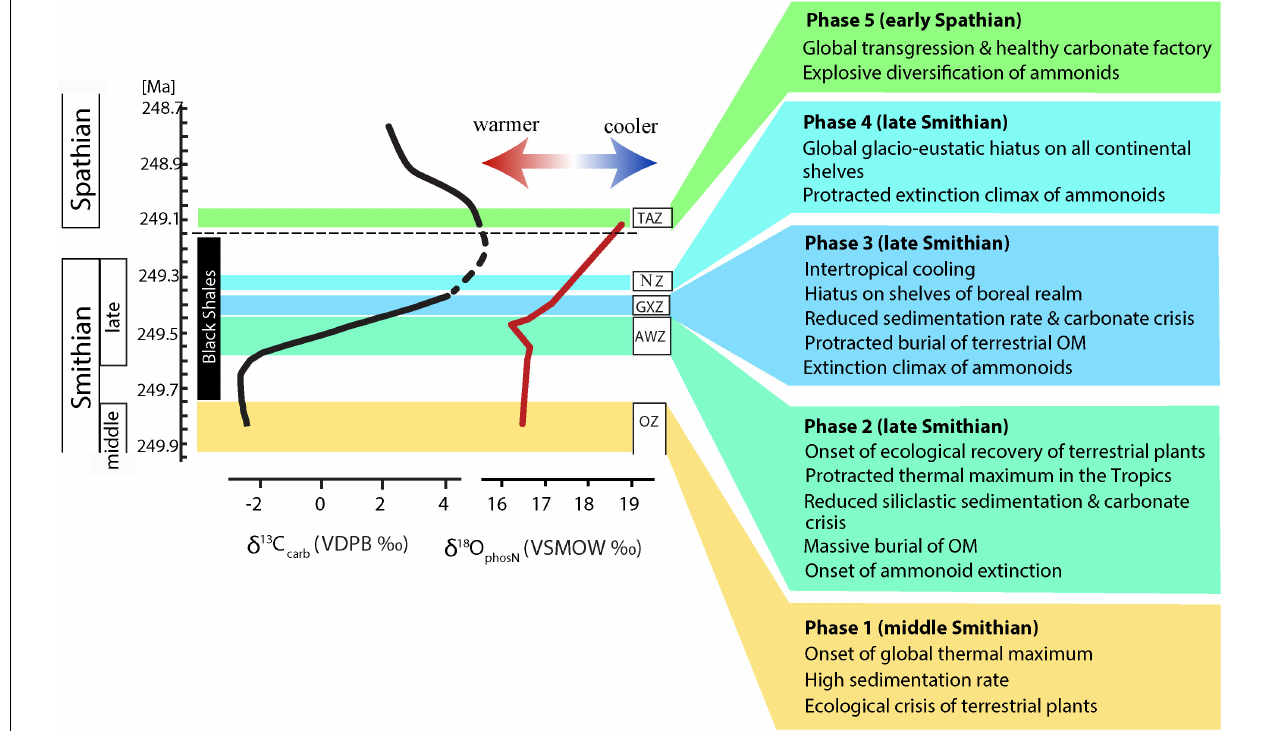
FIGURE 6 | Conceptual model for the timeframe of the subsequent five-phase evolution of global climate, sea-level and ammonoid diversity from the mid-Smithian to basal Spathian, relating the carbon isotope record of this study to δ 18 O phosN (Goudemand et al., 2019) and associated consequences and